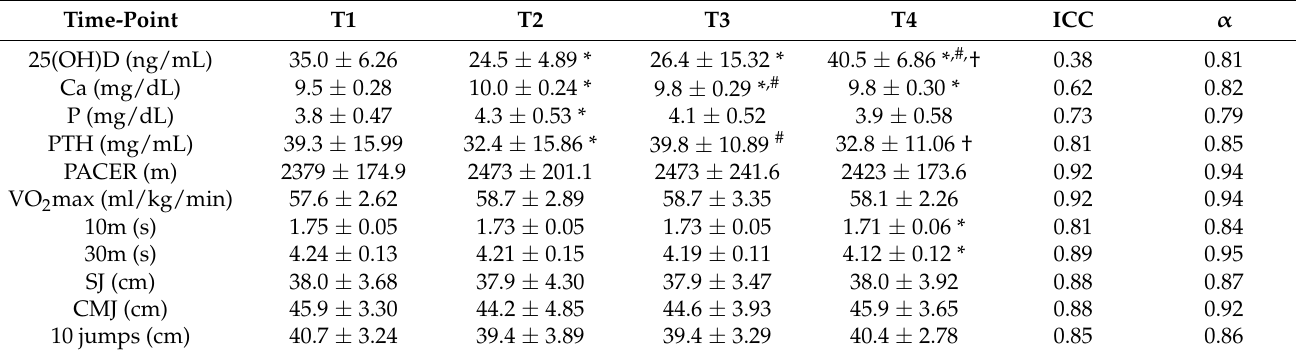
Table 2. Changes in selected biochemical indicators of blood and physical fitness in young soccer players ( n = 24) during a one-year training